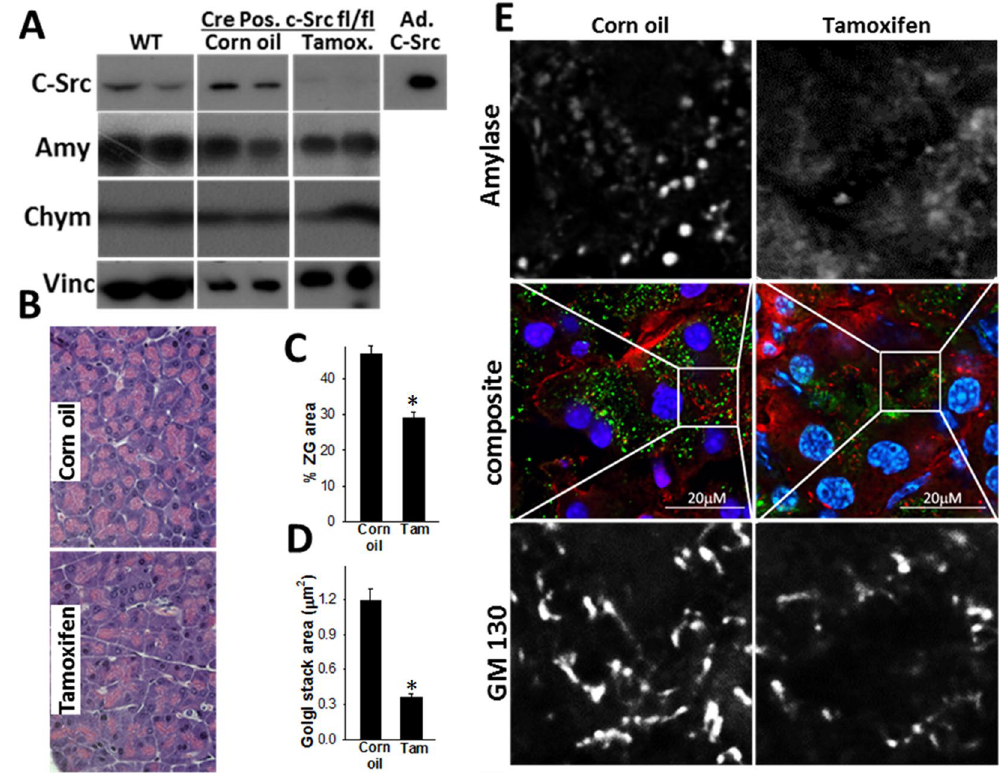
Figure 6. Effect of genetic deletion of c-Src in the exocrine pancreas on zymogen granule, Golgi area and amylase staining. ( A ) Western blots of mouse pancreatic homogenates from C57BL/6 (wild type; WT) mice, Cre positive, c-Src L/L mice given corn oil or Tamoxifen blotted for c-Src (upper panel, with c-Src adenovirus as a positive control), Amylase (Amy), Chymotrypsin (Chy) and vinculin (Vinc) as a loading control. ( B ) Bright field imaging of histological sections of Cre positive, c-Src L/L mice stained with hematoxylin and eosin given corn oil or Tamoxifen. Bar graphs depicting the zymogen granule area as percentage of total acinar cell area ( C ) and area of individual Golgi stacks ( D ) in corn oil or tamoxifen (Tam) treated mouse acinar cells in the pancreas. ( E ) Immunofluorescence images of mouse pancreas stained for amylase (green) and GM130 (red) in corn oil and Tamoxifen treated mice. The greyscale images in the top and bottom row show amylase and GM130 staining of the inset boxes respectively. Note the diffuse amylase staining and smaller Golgi stacks in the Tamoxifen treated mice respectively.